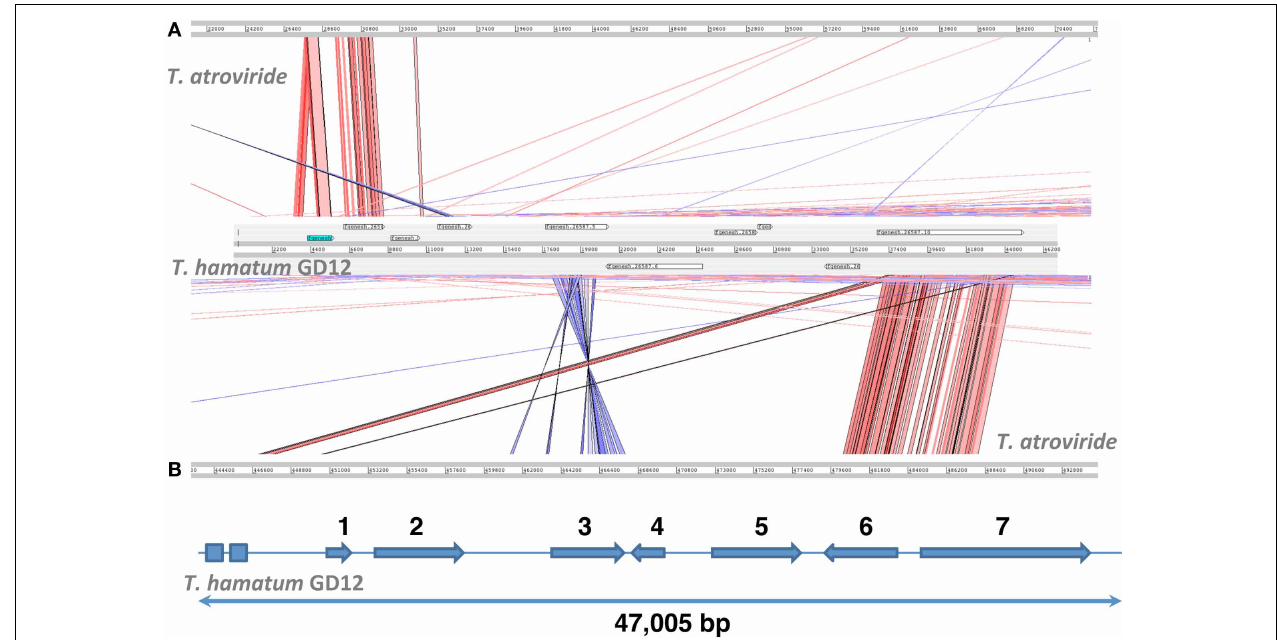
FIGURE 5 | A genomic region unique to Trichoderma hamatum GD12 with the capacity to encode novel secondary metabolites. (A) This 47-kbp region (GenBank: KB232787) has no detectable nucleotide sequence similarity to previously sequenced Trichoderma genomes except